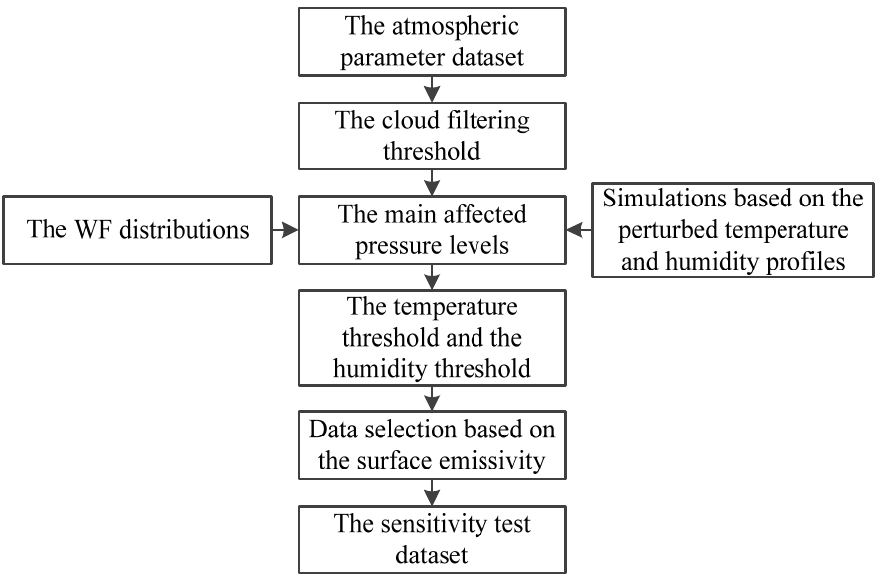
Figure 4. The schematic of building the sensitivity test dataset. Based on the above steps, the sensitivity test dataset for each channel of MWHTS and MWTS-II can be built. Table 4 lists the main affected pressure levels, temperature threshold, humidity threshold, and the number of samples in the sensitivity test dataset for each channel of MWHTS and MWTS-II, where channels with similar WF distributions can share the same configuration of the sensitivity test dataset. For example, H-1, H-7, H-8, H-9, H-10, T-1, and T-2 with peak WF heights are close to the surface, which can use the same sensitivity test dataset. In addition, the temperature threshold affects all channels of MWHTS and MWTS-II, while the humidity threshold affects the window channels H-1 and H-10, the temperature sounding channels H-5, H-6, H-7, H-8, and H-9, and the hu- midity sounding channels H-11, H-12, H-13, H-14, and H-15. Table 4. The configuration of sensitivity test datasets for MWHTS and MWTS-II. Channel